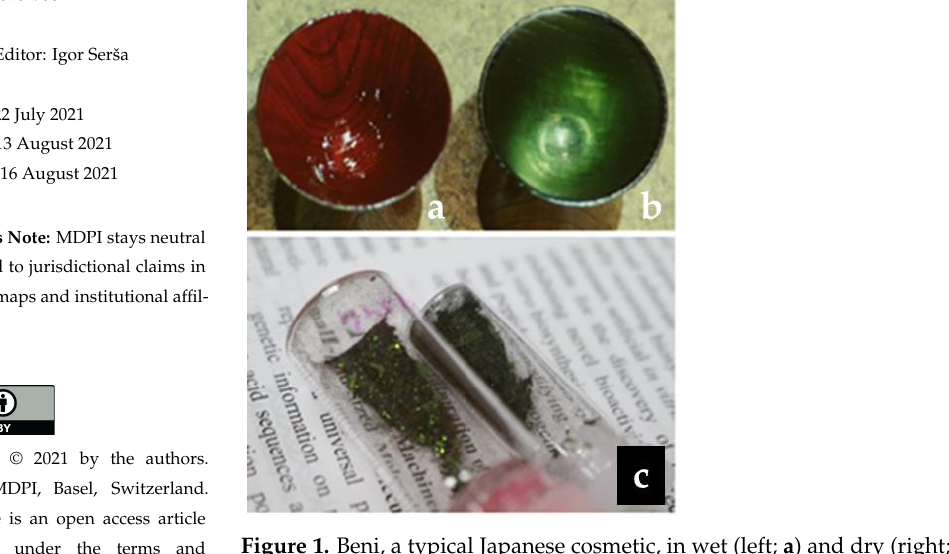
Figure 1. Beni, a typical Japanese cosmetic, in wet (left; a ) and dry (right; b ) states (top). Dried stable beni isolated and purified in this work (bottom; c ).